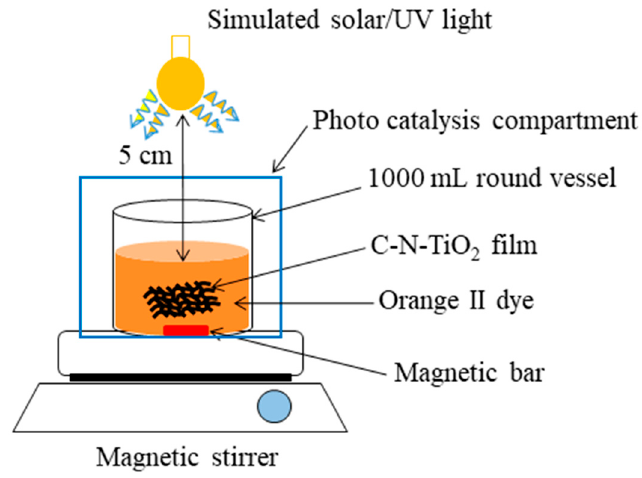
Figure 1. Photo catalysis set up for the degradation of orange II dye at the following fixed parameters: O.II concentration 10 mg / L, volume 500 mL, solution pH 2.5, A solar simulator light ((AM 1.5 radiation, 100 mW / cm 2 ) and a UV lamp (Mega-Ray 160 W / 240 V MR160 SPL11 / 14 from Kimix) and irradiation time 120 min. Varied parameters: type of uncoated or coated meshes.